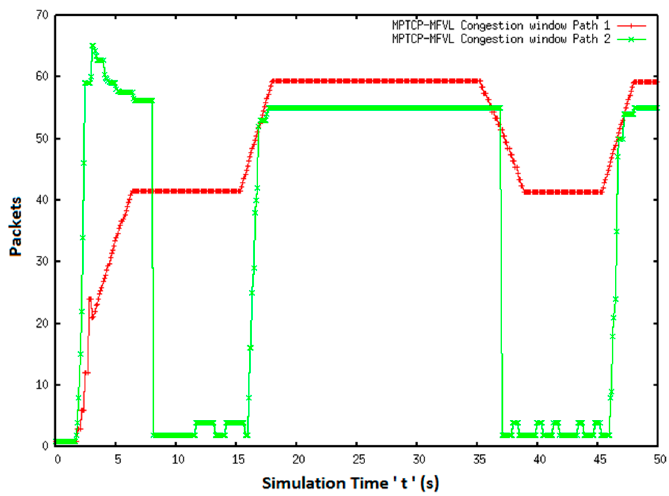
Figure 12. Congestion window graphs when MVegas congestion control is used on subflow with less congested path (Path 1), and MFast is used on subflow with more congested path (Path 2).